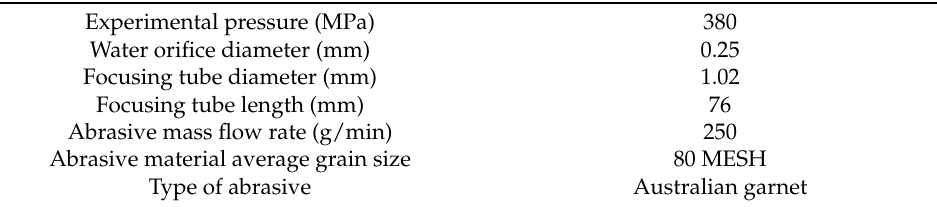
Table 1. Setup of basic experimental variables of the abrasive waterjet (the fixed variables).